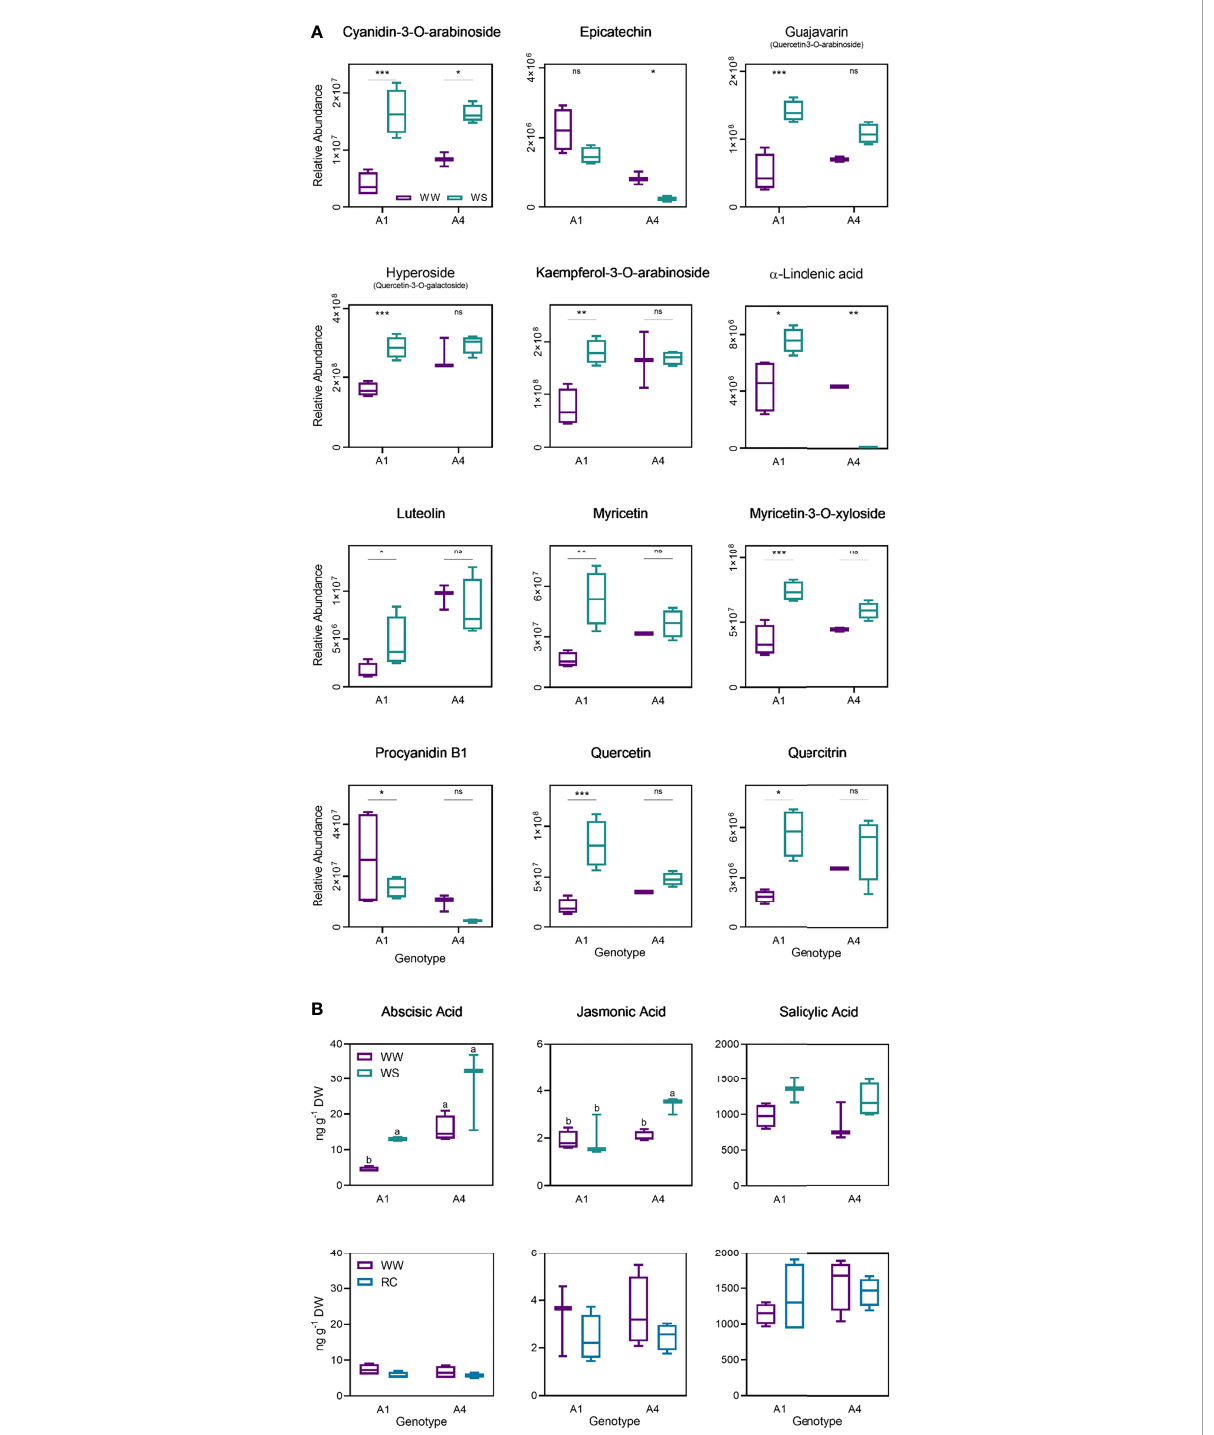
FIGURE 7 Relative abundance of cyanidin-3-O-arabinoside, epicatechin, guajavarin, hyperoside, kaempferol-3-O-arabinoside, a -linolenic acid, luteolin, myricetin, myricetin-3-O-xyloside, procyanidin B1m quercetin and quercitrin on well-watered and water stress groups from A1 and A4 genotypes on t2 (20 days) (A) , abscisic acid, jasmonic acid and salicylic acid on well-watered and water stress groups from A1 and A4 genotypes on t2 (20 days) and t3 (20 + 5 days) (B) . Means ± SDs, n = 3-4, different letters indicate signi fi cant differences between treatments at P ≤ 0.05, according to a Tukey ’ s multi comparison test. * P value <0.05, ** P value <0.01, *** P value <0.001, ns, non signi fi cant (P >